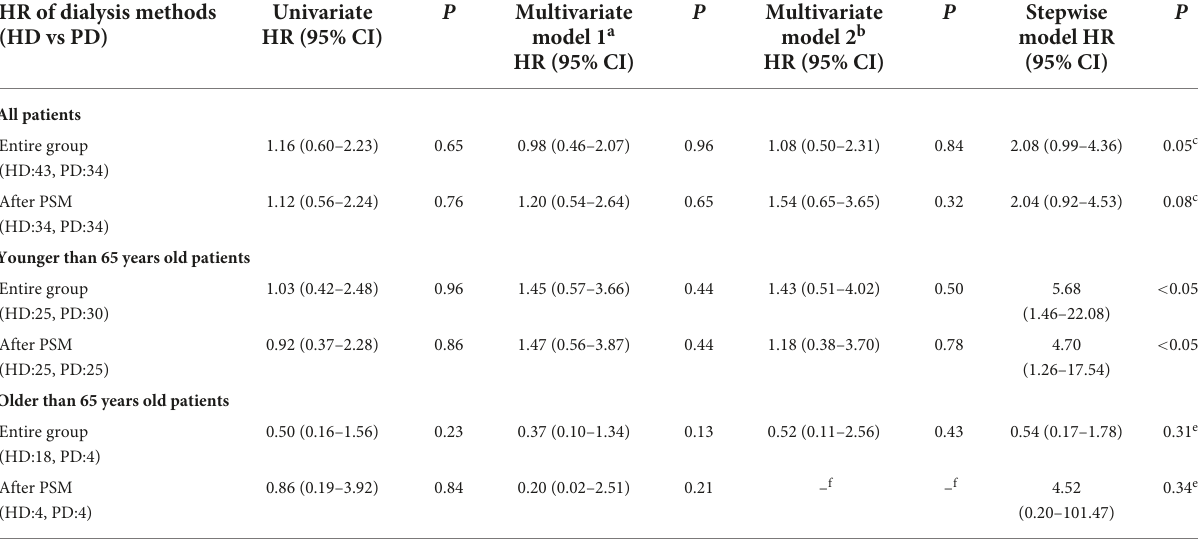
TABLE 5 Crude and adjusted hazard ratios for all-cause mortality with HFrEF (LVEF ≤ 55%) according to dialysis method. HR of dialysis methods (HD vs